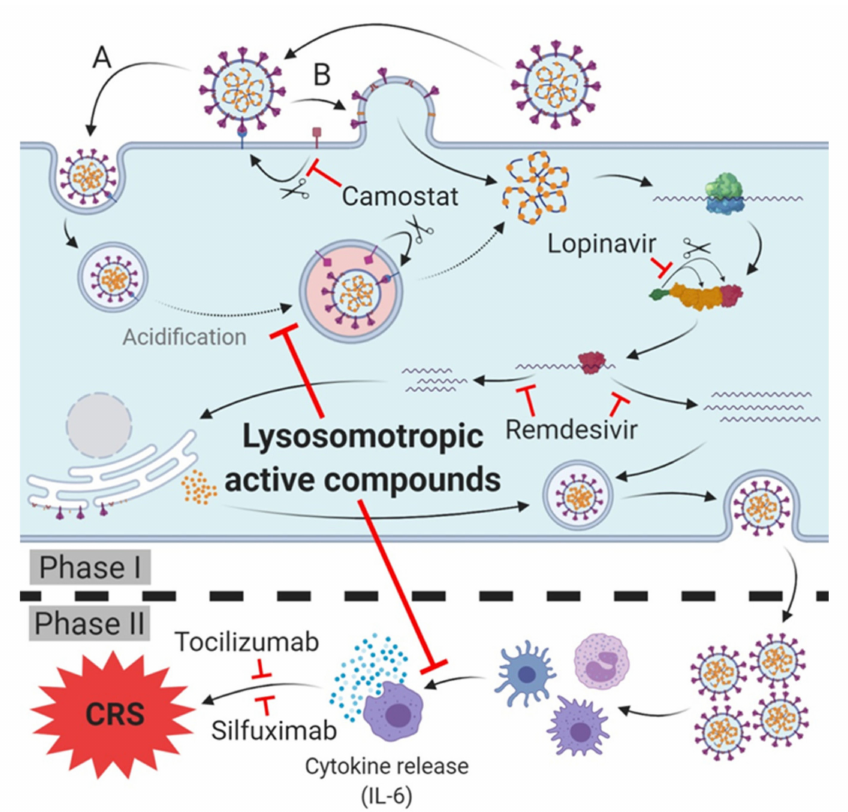
Figure 2. Therapeutic targets and lead compounds for treatment of SARS-CoV-2 infection / COVID-19. Phase I (host cell infection): TMPRSS2: Camostat inhibits protease activity, blocking SARS-CoV-2 host cell entry (variety ( B )). 3CL pro : Lopinavir inhibits cleavage of the polyprotein, leading to diminished (activity of) subsequent non-structural proteins (nsp). RNA-dependent RNA polymerase (RdRp): RemdesivirinhibitssynthesisofviralmRNAandprogenygenomes. PhaseII (cytokinereleasesyndrome (CRS) / cytokine storm of COVID-19): Antibodies of IL-6 receptor (tocilizumab) or IL-6 (silfuximab) neutralize released IL-6 or block its receptor and prevent cytokine release syndrome (CRS) / cytokine storm and deterioration of SARS-CoV-2 infection into COVID-19. Phase I and II : Lysosomotropic active compounds prevent the acidification of endosomes, raise lysosomal pH and inhibit SARS-CoV-2 endosomal host cell entry (variety ( A )). Expression of pro-inflammatory chemokines / cytokines in antigen presenting cells (APC) is diminished, thus preventing the cytokine release and CRS / cytokine storm and deterioration to